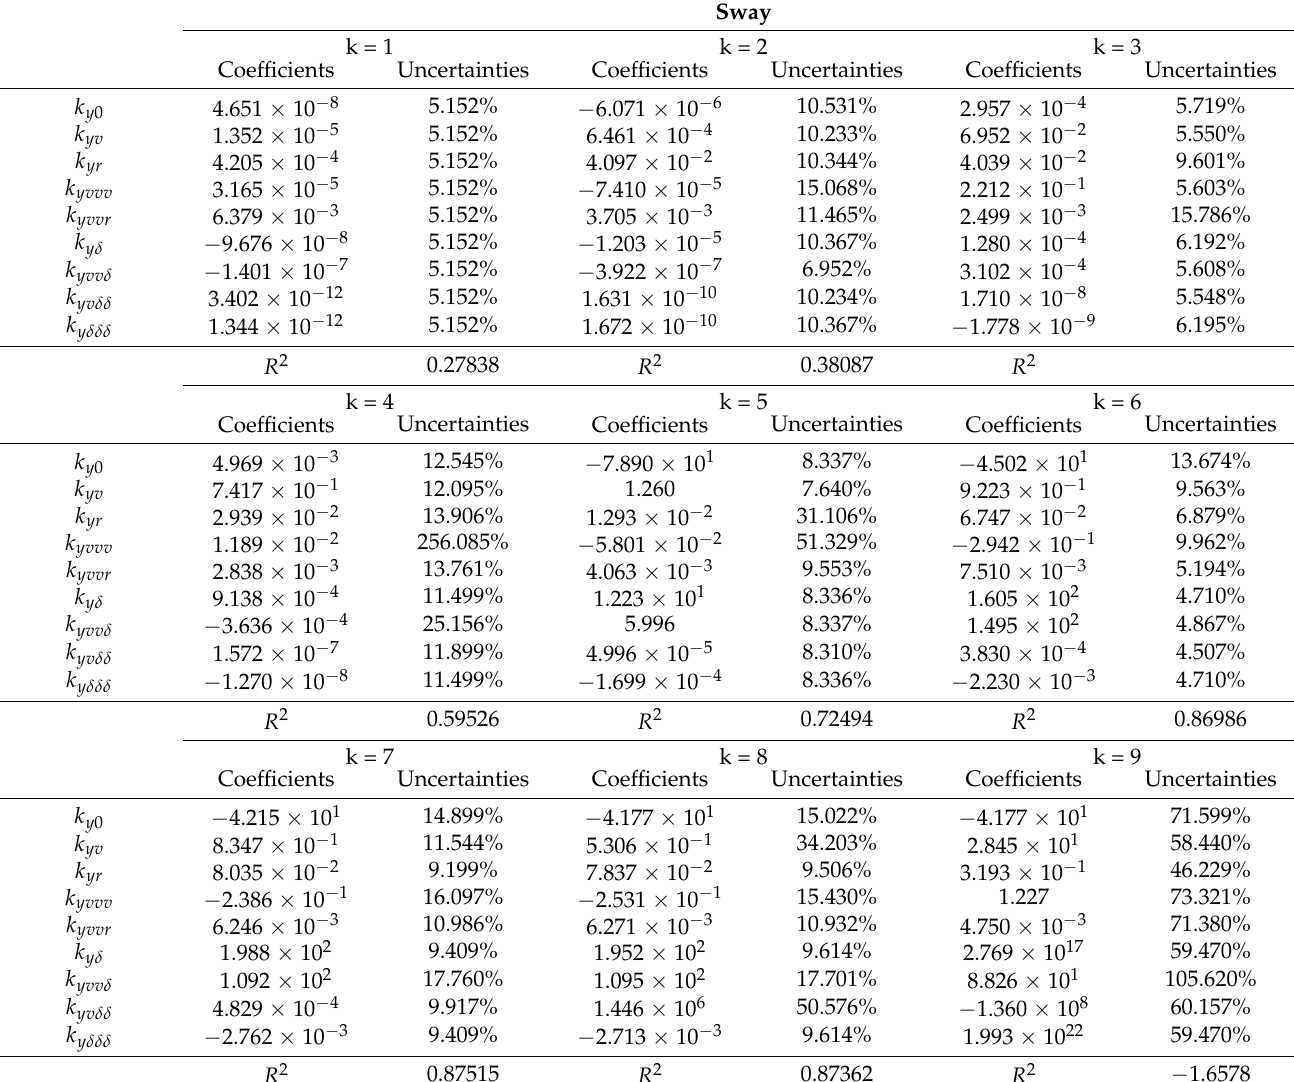
Table 6. Sway adjustment coefficients and uncertainties for tests’ data from the 30 ◦ − 30 ◦ zigzag